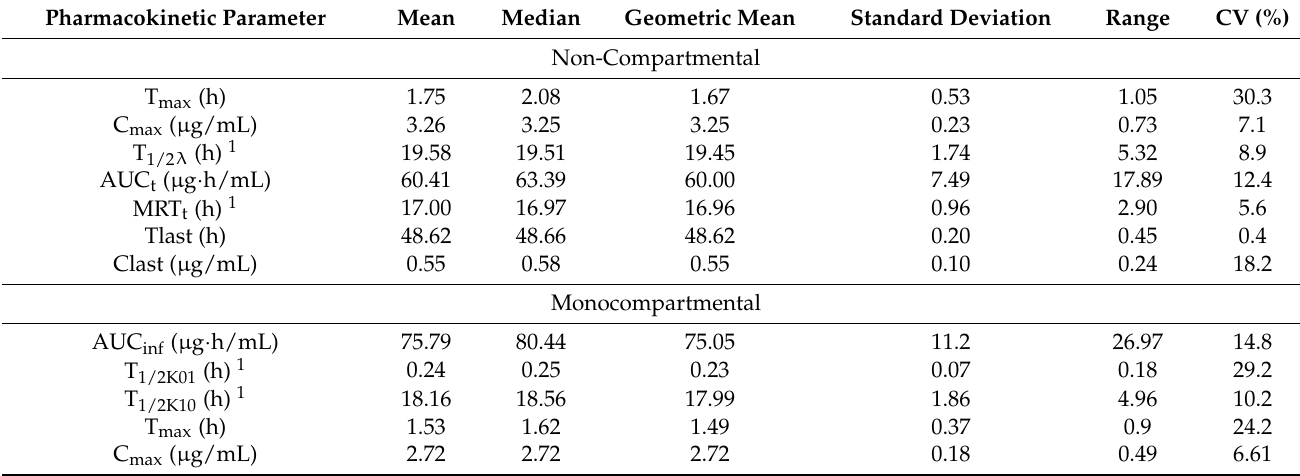
Table 1. Pharmacokinetic parameters obtained after enrofloxacin intramuscular administration (10 mg/kg) in black vultures ( Coragyps atratus ) ( n = 6).